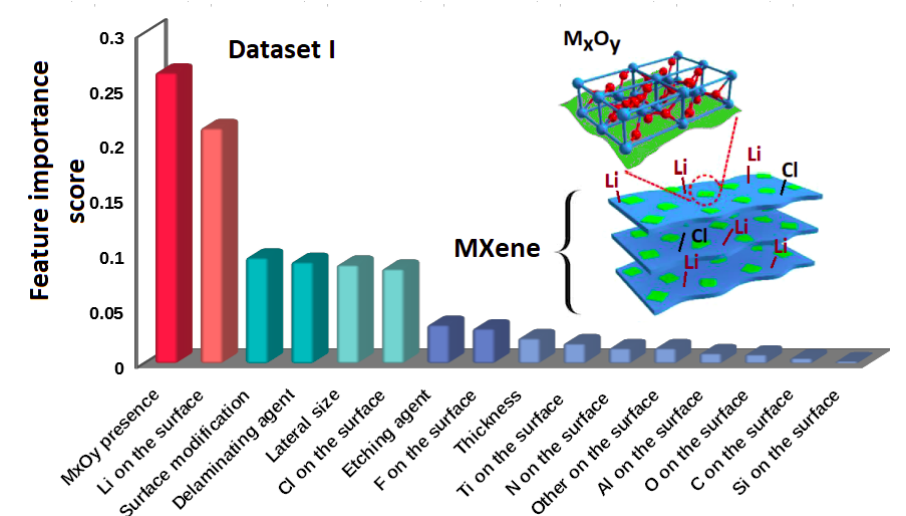
Figure 2. Ranking of feature importance obtained from RF. The most important are two descriptors: (i) the presence of M x O y , and (ii) Li on the surface, whereas the next four: surface modification, delaminating agent, lateral size, and Cl on the surface are equally important with smaller weights than the previous two. All feature labels are described in Table